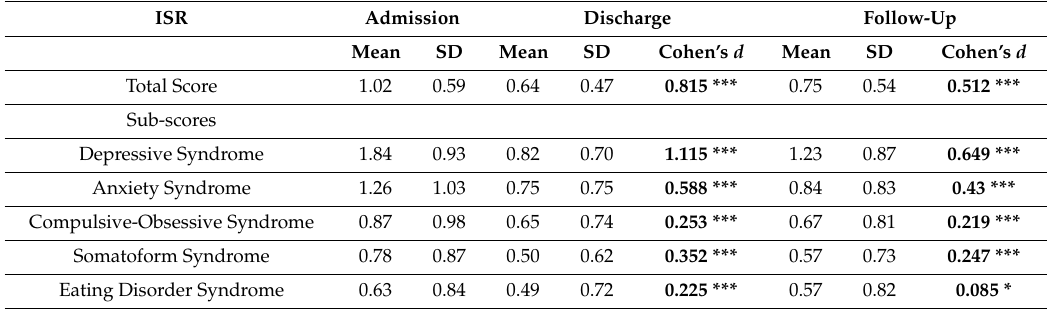
Table 2. Comparison of symptom loads between admission and discharge and admission and follow-up of 759 patients with complete data sets.